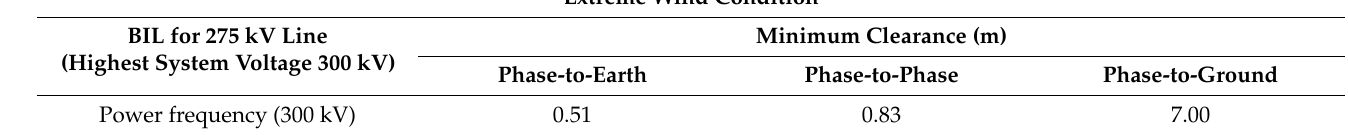
Table 4. Proposed suspension string insulator.